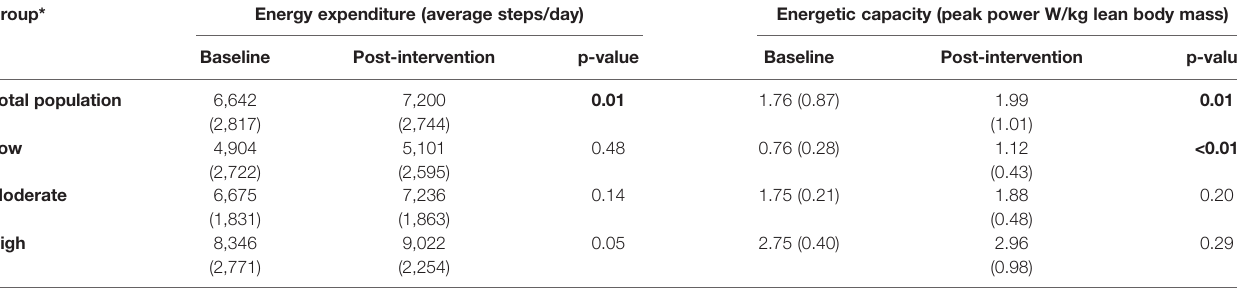
TABLE 2 | Comparison of energy expenditure and energetic capacity at baseline and post-intervention.